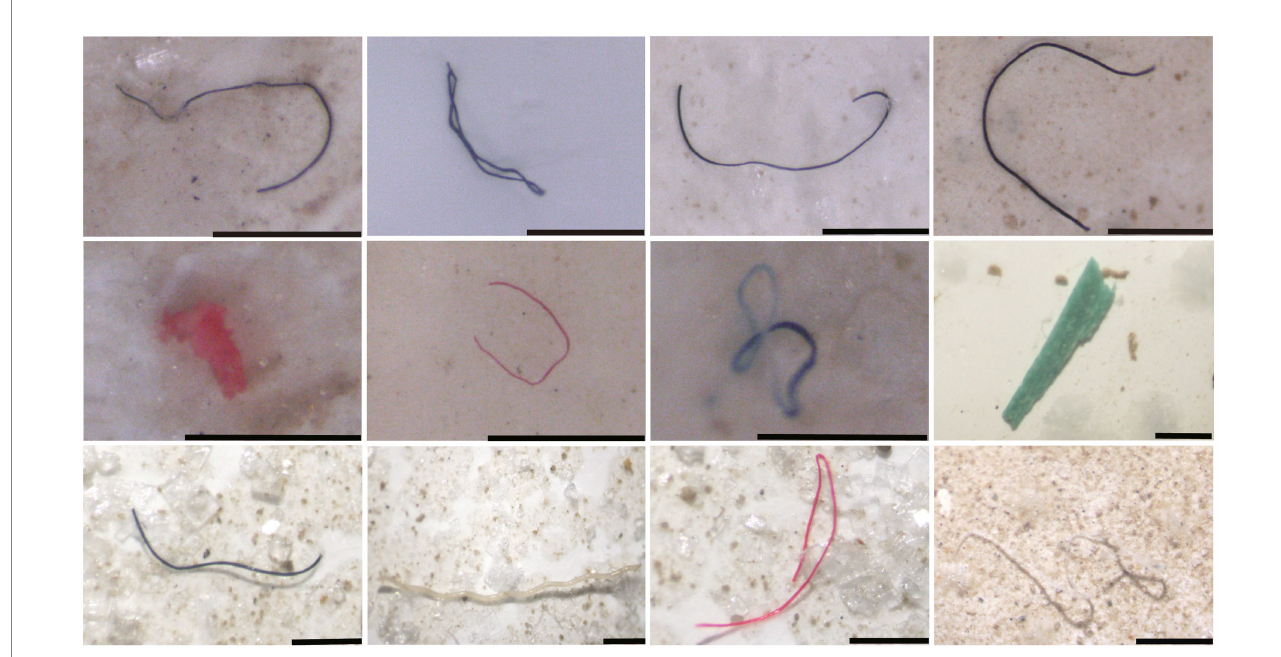
FIGURE 1 Microplastics in the coast of Qingdao, China. The black line refers to 500 μ